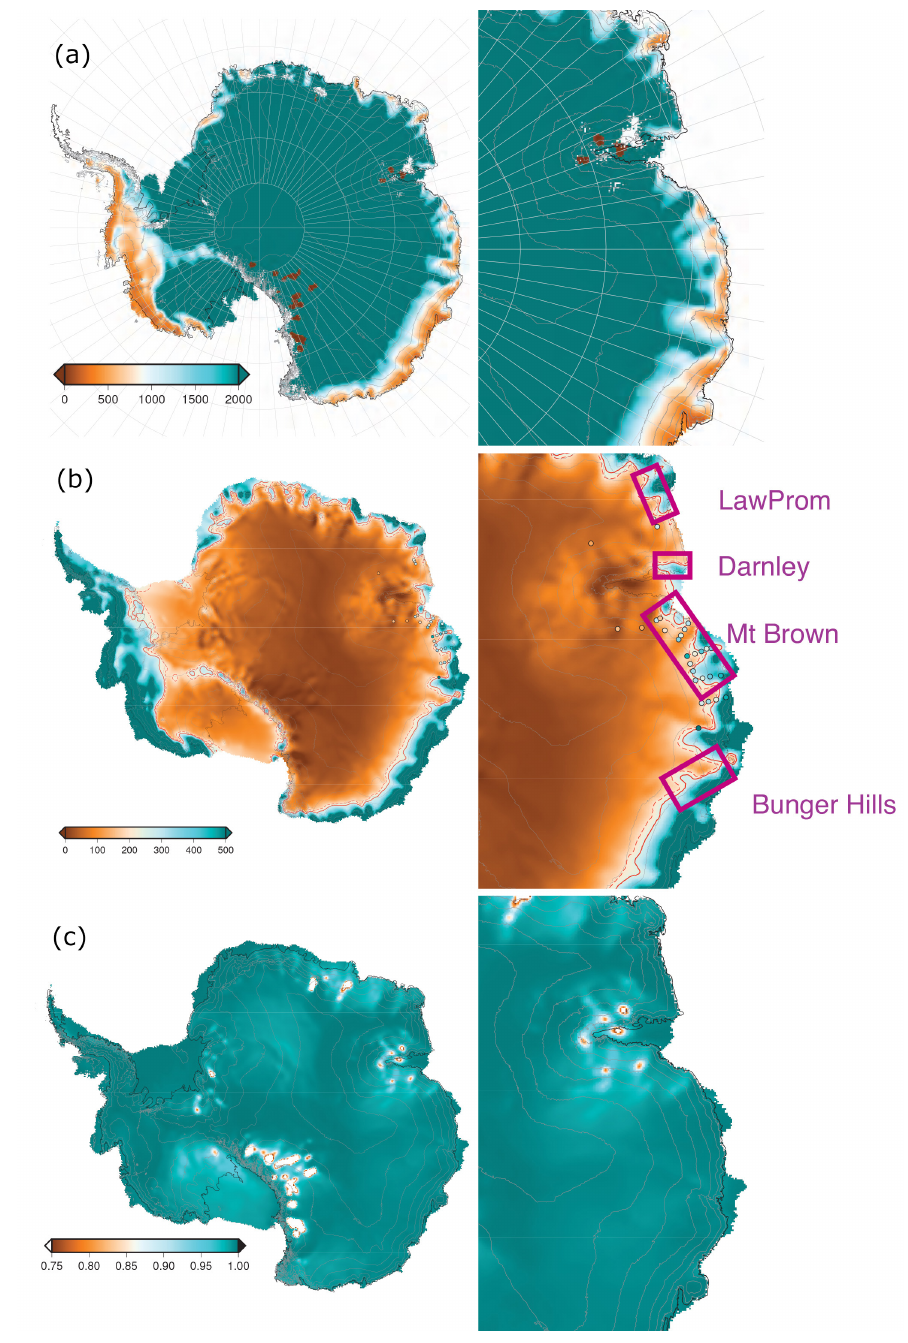
Figure 1. Assessing continental East Antarctica for areas that fulfil the specified high-resolution, multi-millennial record length site criteria for this study, with all of Antarctica on the left and the Indian Ocean sector of East Antarctica on the right. Contour intervals (grey) are 500m. Panel (a) shows ice age at 300m (colour bar) using the process described previously. Panel (b) shows annual snowfall accumulation rate, with areas that receive > 250mmyears − 1 IE shown using a solid red boundary, and areas that receive > 200mmyears − 1 IE shown using a dashed red boundary. Panel (c) is a representation of uniformity of snowfall accumulation through the year (blue represents more seasonally uniform accumulation). Labelled boxes in panel (b) identify possible sites after site criteria 1–3 are assessed; see the “Results” section for more detail. LawProm: Law Promontory–Enderby Land region; Darnley: Cape Darnley region; Mt Brown: Mt Brown region; Bunger Hills: Bunger Hills